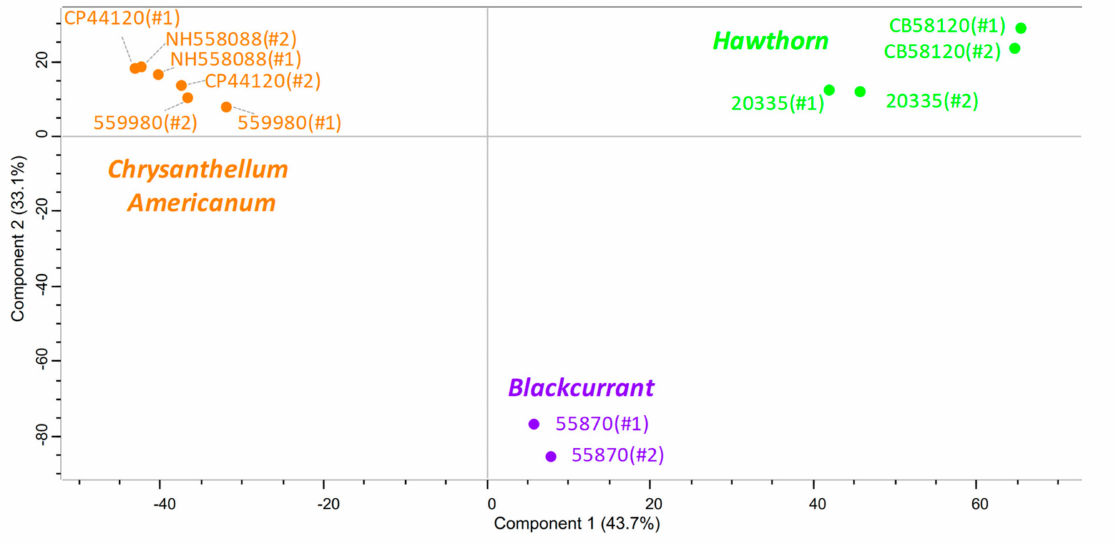
Figure 5. PCA score plot of all mass features measured by ESI(-) FT-ICR MS issued from HAW (green, lot numbers: CB58120 and APC27031904), BC (purple, lot number: 55870), and CA (orange, lot numbers: 559980, CP44120 and NH558088) extracts. The annotations #1 and #2 refer to the replicate